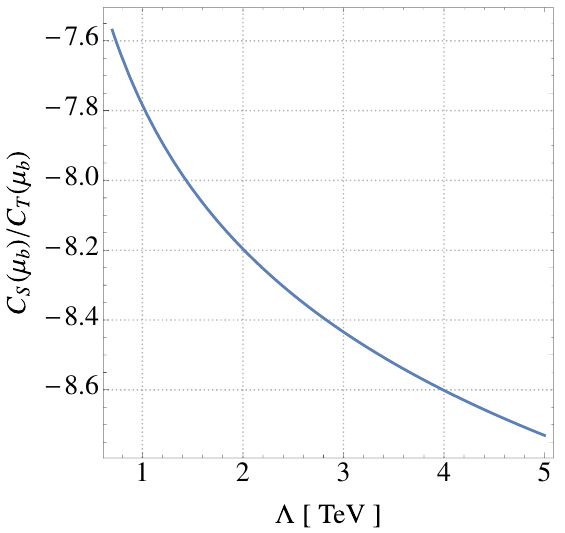
Figure 1. The dependence of the ratio of the tensor and scalar Wilson coe(cid:14)cients evaluated at (cid:22) in b ! c‘(cid:23) as a function of the new-physics scale (cid:3), at which the ratio is (cid:0) 4. The (cid:12)gure depicts the values down to which the ratio C evolves at (cid:22) . For example, running from 1 TeV to (cid:22) S =C T b implies C = (cid:0) 7 : S =C T